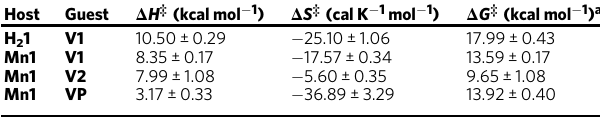
Table 2 Activation enthalpies, entropies and free energies of dissociation for different host – guest